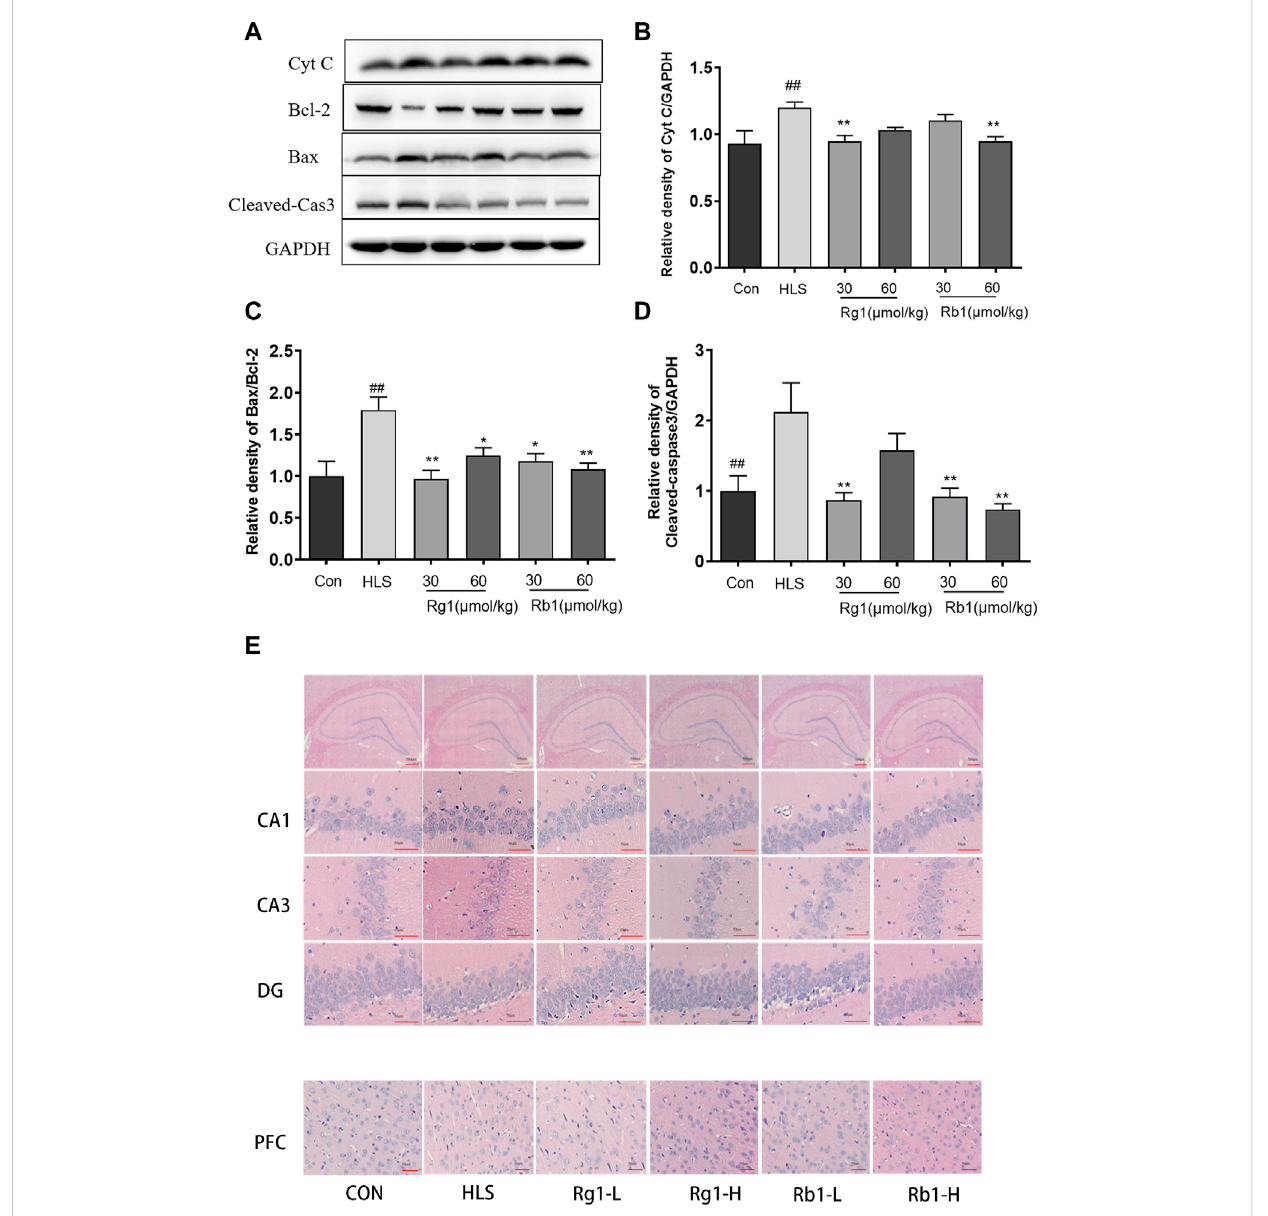
FIGURE 6 The effects of ginsenosides Rg1 and Rb1 on apoptosis, levels of apoptosis-associated proteins, and neuronal cell loss in hindlimb suspension (HLS) rats. (A – D) ProteinbandsandrelativeexpressionlevelsofCytC,Bcl-2/Bax,andcleaved-caspase3inthePFC. (E) TheHLSrathippocampalCA1,CA3,DG, andPFCregionswerestainedwithhematoxylin-eosin (at×400magni fi cationpower).Datarepresentmeans±SEM; N =4ratspergroup. # p < 0.05, ## p < 0.01, signi fi cantly different from control; * p < 0.05, ** p < 0.01, signi fi cantly different from HLS